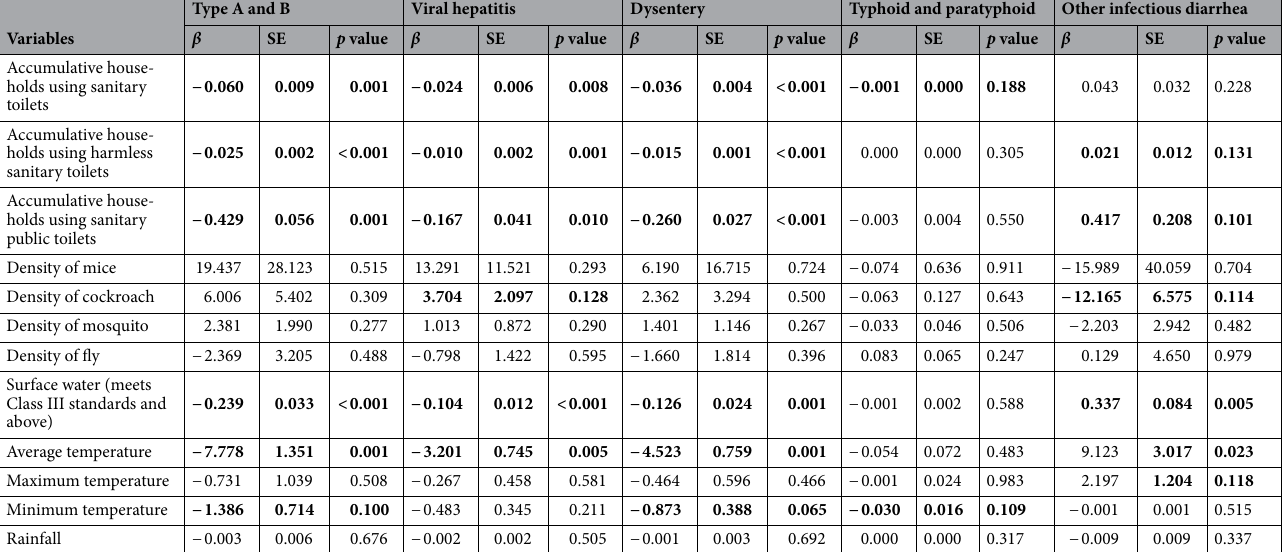
Table 3. Association between the aggregate annual incidence of Type A and B intestinal infectious diseases and various factors in Jiangsu Province. Bold characters signify Sig at p <